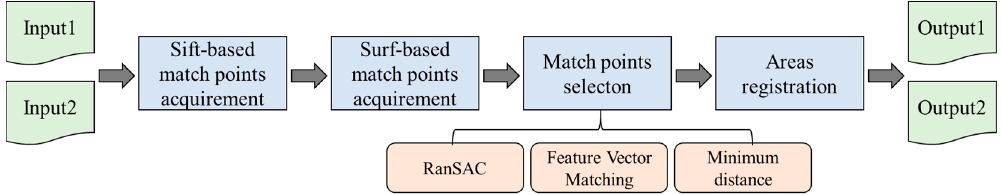
Figure 2. The workflow of areas registration.